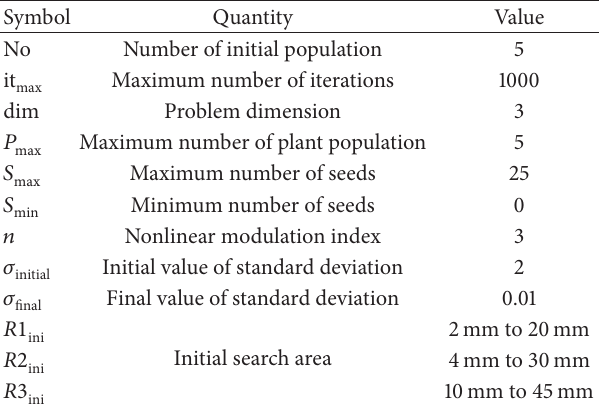
Table 1: IWO parameters values for Figure